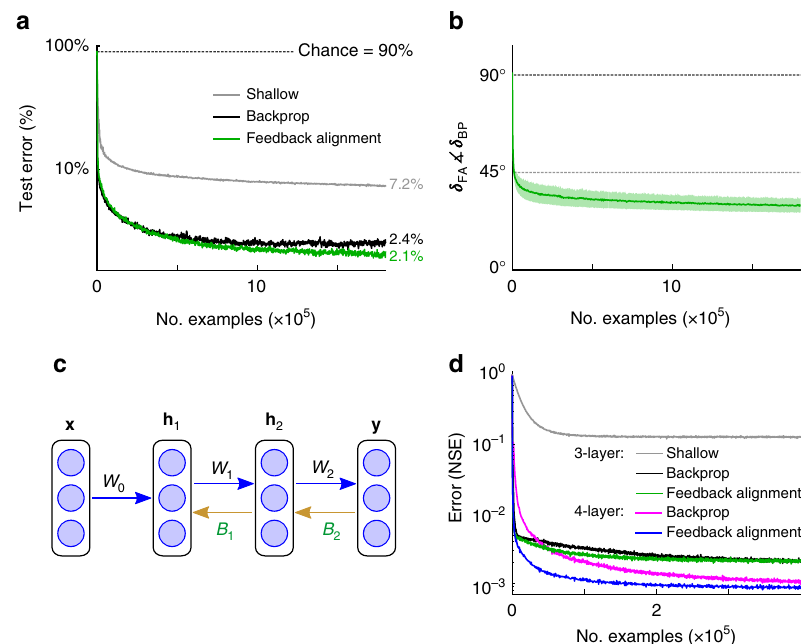
Figure 3 | Feedback alignment works in multilayer networks comprised of nonlinear neurons. ( a ) A 784-1000-10 network of logistic units learns to recognize handwritten digits. Curves show performance by backprop (black), feedback alignment (green) and shallow learning (grey) on 10,000 test images. ( b ) In the nonlinear case shown in a , the modulator vectors prescribed by feedback alignment and backprop also align. Error bars are one s.d. around the time-averaged mean. ( c ) Feedback alignment can train deep networks. ( d ) Error curves for a nonlinear function-approximation task, for a three-layer network trained with shallow learning (grey), backprop (black) or feedback alignment (green), and for a four-layer network trained with backprop (magenta) or feedback alignment